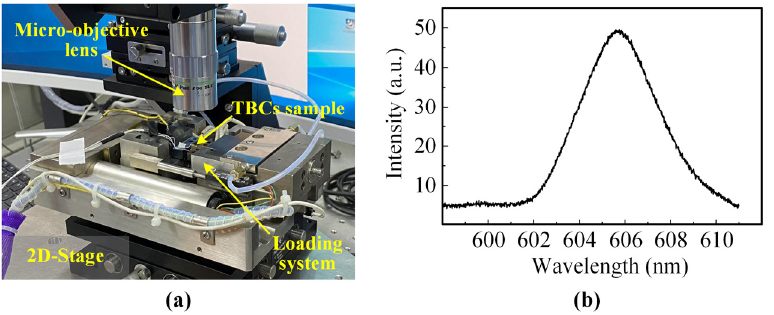
Figure 2. ( a ) The experimental system used for calibration tests; ( b ) a typical Eu 3+ fluorescence spec-